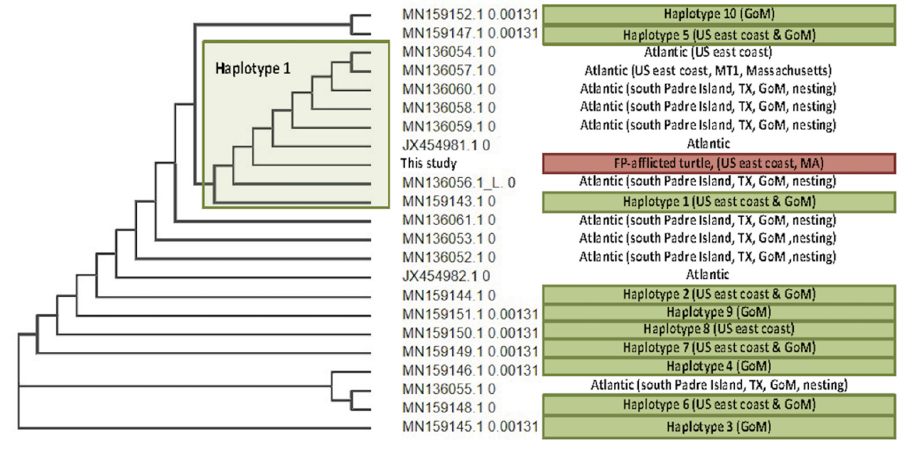
Figure 4. Mitochondrial DNA analysis of tissue samples collected from a Kemp’s ridley sea turtle ( Lepidochelys kempii ) that stranded in Massachusetts, USA ( Lk15 ), alongside other published Kemp’s ridley mitochondrial D-loop control regions [44,45]. Lk15 (shaded red) grouped within the haplotype 1 sub-group. Haplotype defining sequences are shaded green. Kemp’s ridley turtles along the east coast USA are 80% likely to be haplotypes 1 and 2 (predominantly haplotype 1), and 79% of haplotypes 1 and 2 originate from rookeries along the Texas coast. Combined with ChHV5 phylogenetic data (Section 3.4, Figures 6 and 7), these results suggest that Lk15 likely originated from Texas (based on currently available data) and harbors a Florida variant of ChHV5.